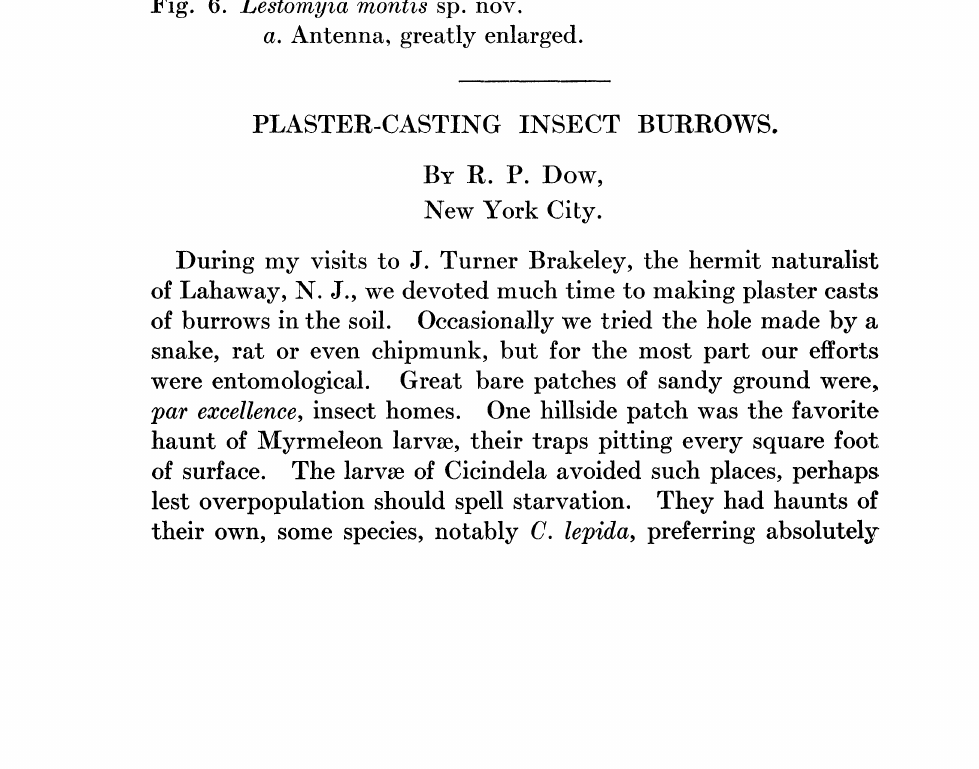
Fig. 1. Nicocles lomoe sp. nov. a. Antenna, greatly enlarged. Fig. Plate VIII. Fig. 3. Lasiopogon drabicolum sp. nov. a. Antenna, greatly enlarged. Fig. 4. Cophura highlandica sp. nov. Plate IX. Fig. 5. Metapogon picture sp. nov. a. Head fr6m side. b. Outline of head from front. Fig. 6. Lestomyia montis sp. nov. a. Antenna, greatly enlarged. PLASTER-CASTING INSECT BURROWS. By R. P. Dow, New York